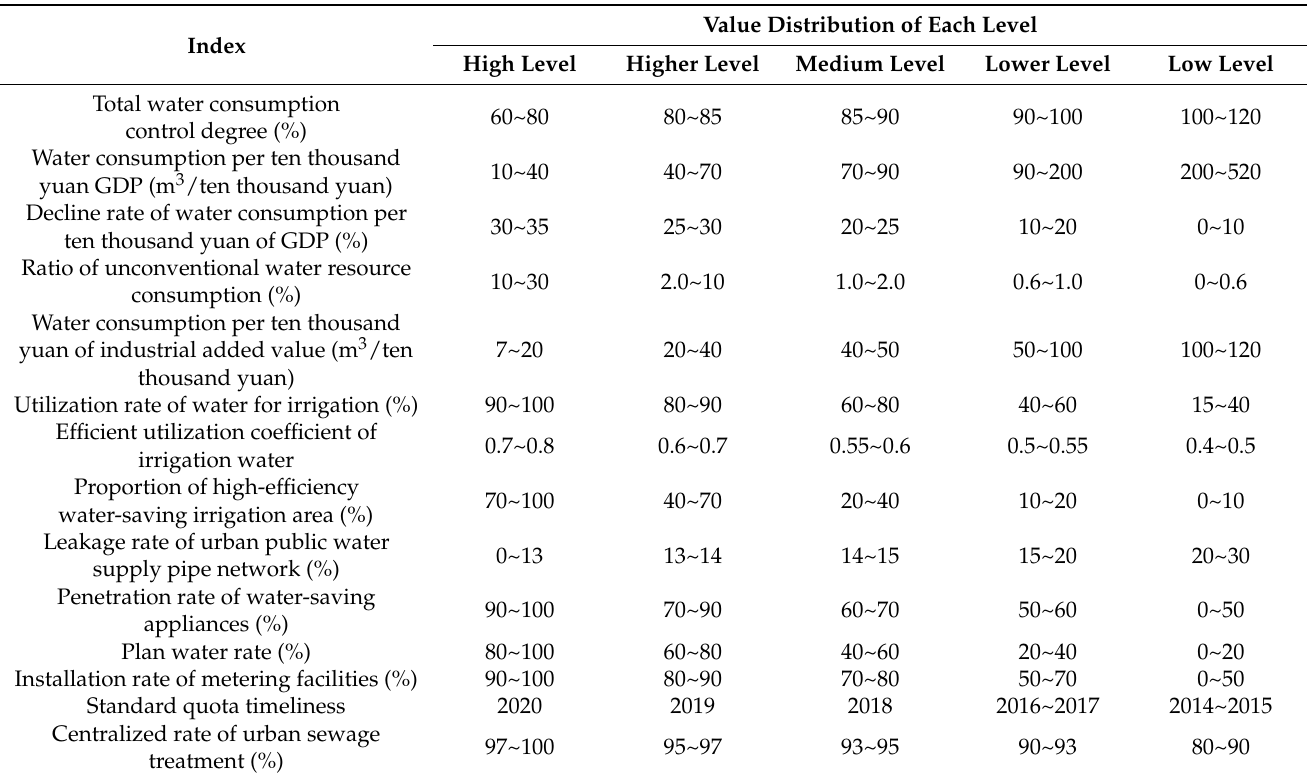
Table 2. Threshold division of each indicator at each